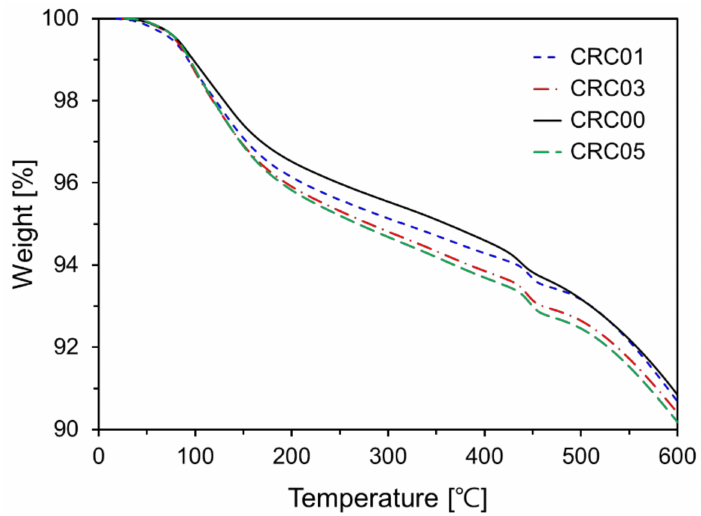
Figure 14. TG analysis